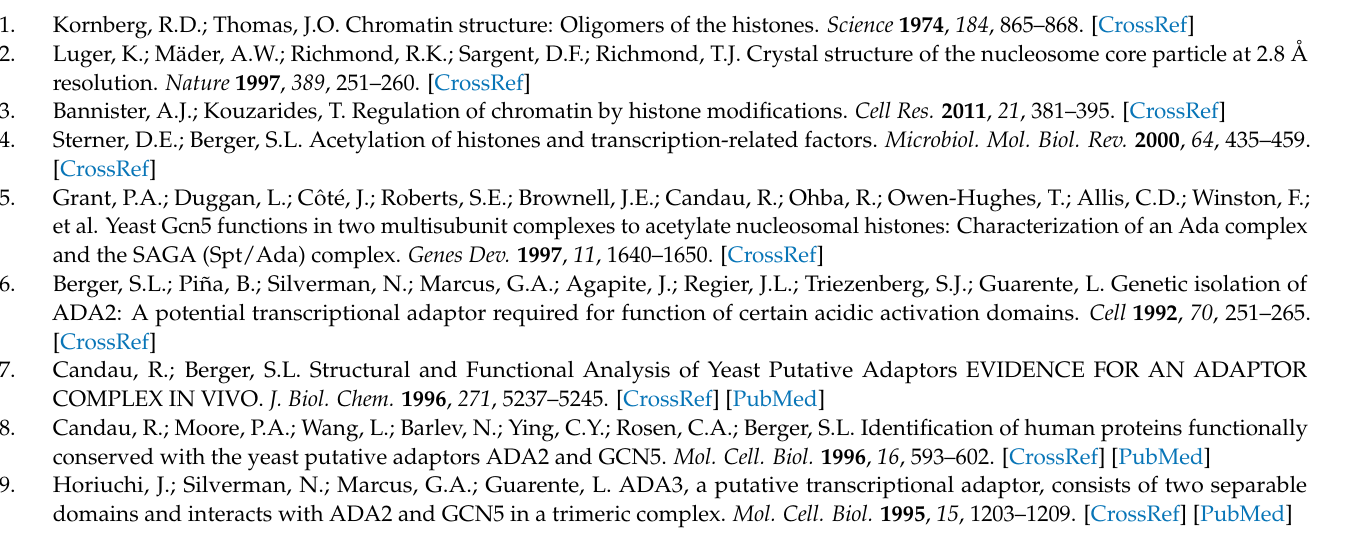
genome; Figure S2: Secondary structure of Arabidopsis ADA3 proteins; Figure S3: ADA3 proteins from species of Brassicaceae family; Figure S4: Discovery of Amino acids Motif in ADA3 proteins; Figure S5: mRNA expression levels of ADA3a and ADA3b in various organs and tissues; Figure S6: Predicted subcellular localisation of ADA3a and ADA3b proteins; Figure S7: Gene expression of GCN5, ADA2a and ADA2b in ada3 mutants; Figure S8: Flowering phenotypes of ada3a-1 and ada3b-1 mutant plants grown under LD conditions; Figure S9: Gene expression of flowering related genes; Table S1: Oligonucleotide sequence of primers used, Table S2: Flowering in ada3a-1 and ada3b-1 mutants; Dataset S1: Accession number of ADA3 protein in